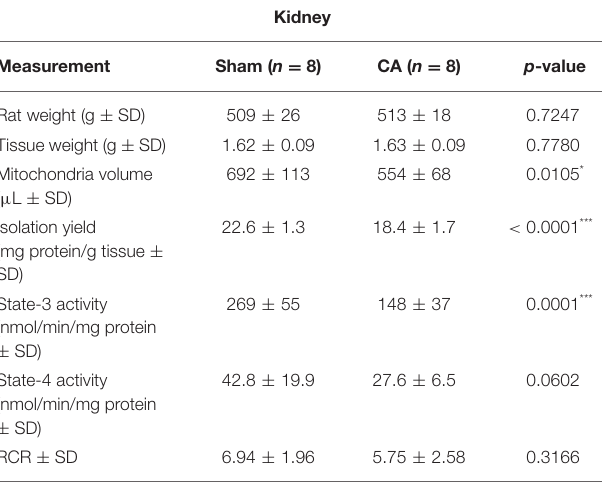
TABLE 2 | Basal characteristics and oxygen consumption rates of the isolated mitochondria from the